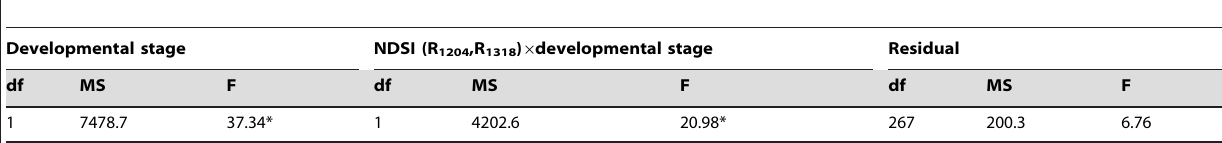
Table 2. Simple grouping linear analysis of the model between NDSI and LEWT in wheat before and after anthesis.